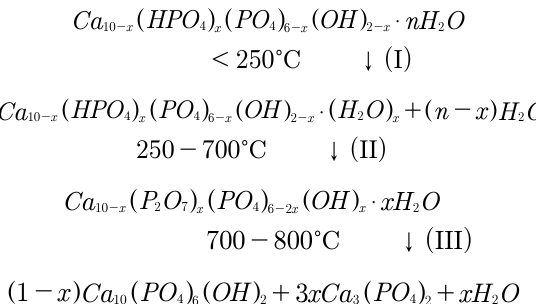
Figure 3: FTIR spectra of (a) calcined and (b) uncalcined